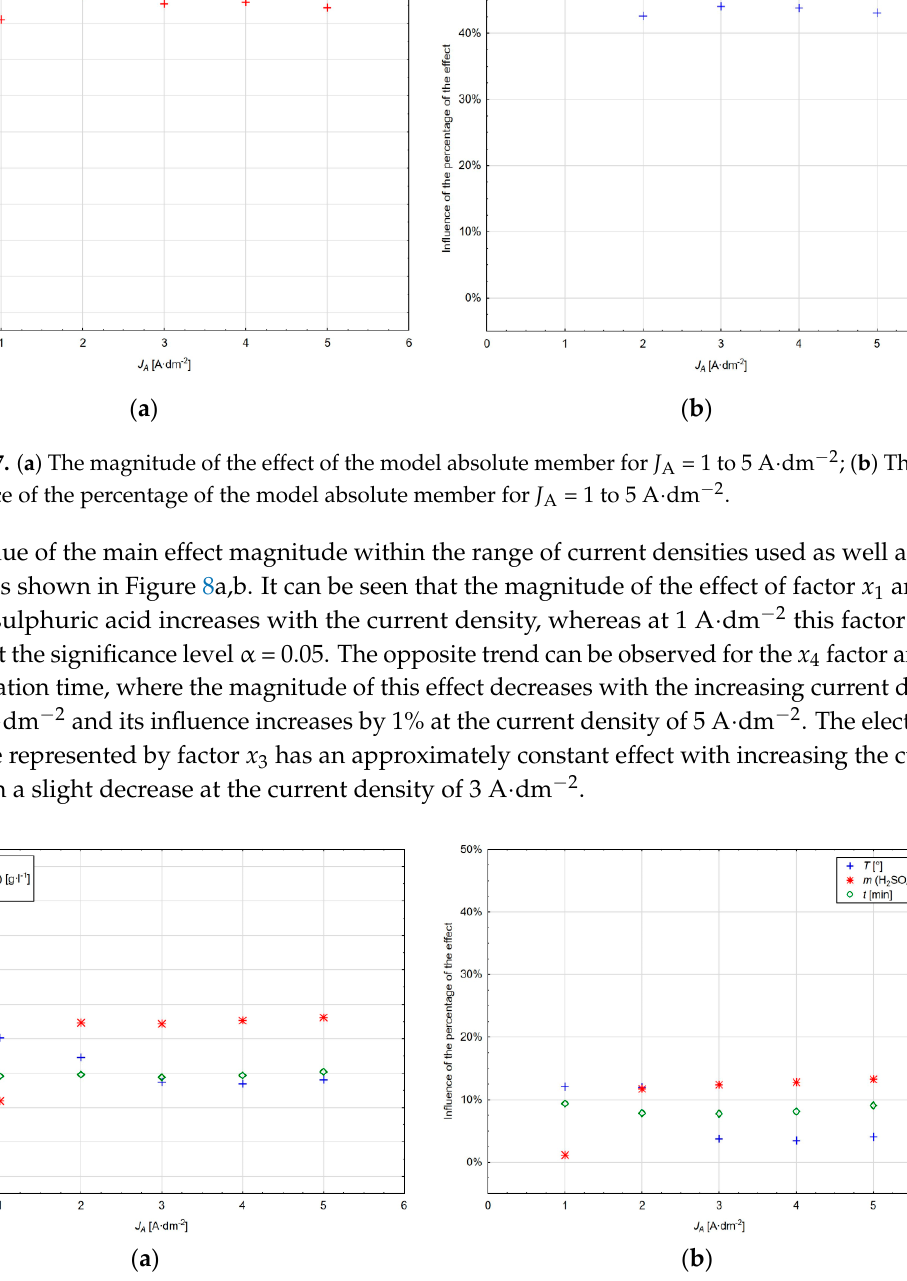
Figure 8. ( a ) The magnitude of the main model effects for J A = 1 to 5 A·dm − 2 ; ( b ) The influence of the percentage of the main model effects for J A = 1 to 5 A·dm − 2 .